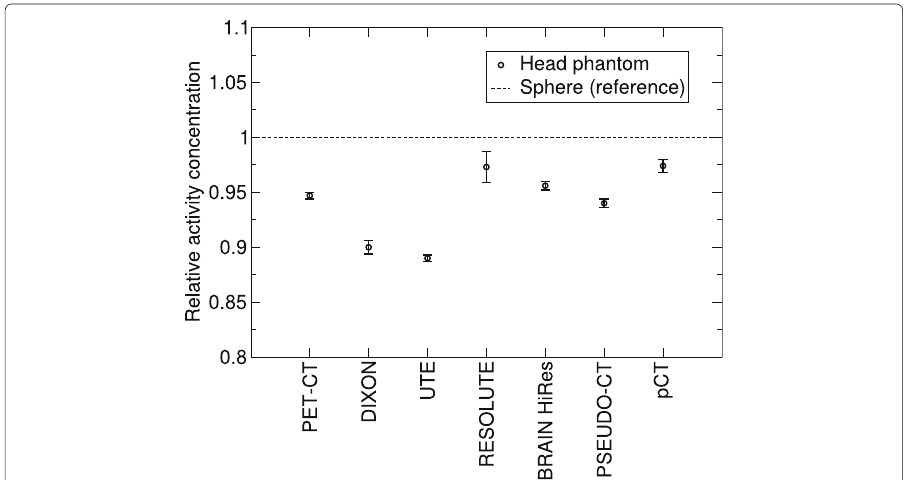
Fig. 3 Comparison of the measured activity concentration between the spherical phantom and the created PET-MRI phantom. The error bar is the standard deviation calculated over six repeated measurements